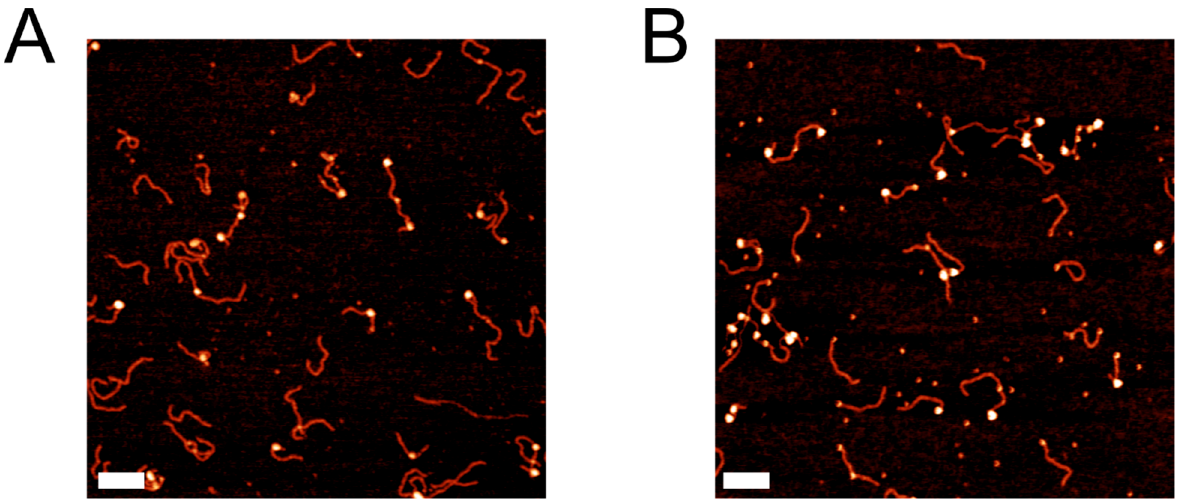
Figure 2. Representative images of CENP-A nucleosomes ( A ) and H3 nucleosomes ( B ) assembled on the α -satellite DNA substrate labeled with streptavidin. Scale bars indicate 100 nm.